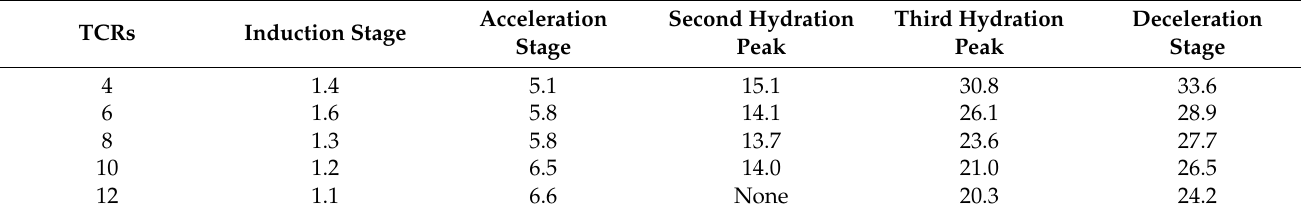
Table 3. Variation in hydration exothermic rate for different TCRs